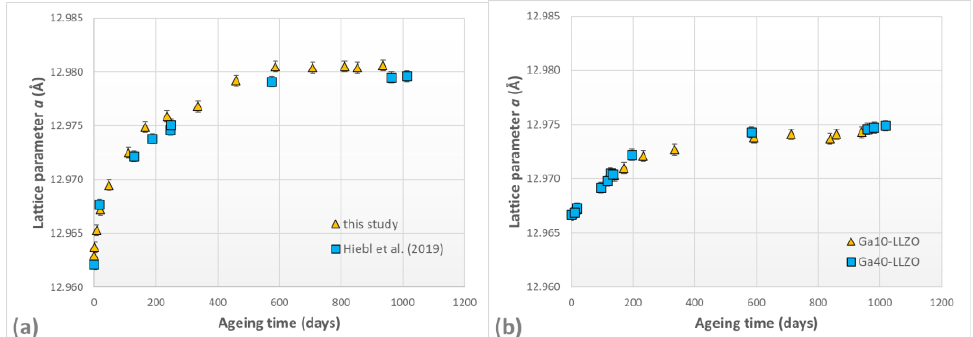
Figure 4. Variation of lattice parameters of ( a ) the Al10-LLZO single crystal and ( b ) two different compositions of Ga 3+ stabilized LLZO, exposed to humid air.